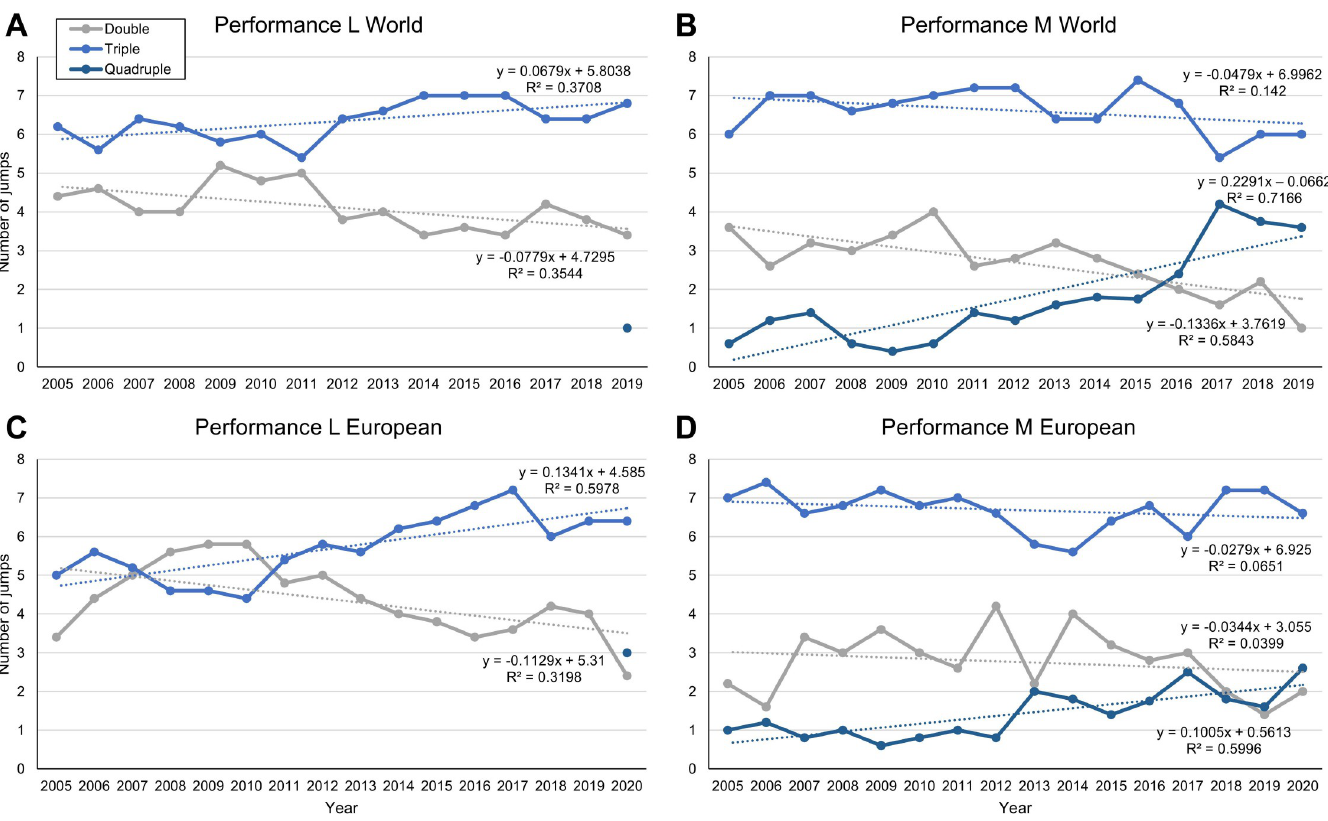
Fig 2. Trends of the average number of double, triple and quadruple jumps. Trends of the average number of double, triple and quadruple jumps of the best five female (L) and male (M) athletes each who competed in the singles categories at the European and World Figure Skating Championships since the year 2005. Regression analysis was performed to show trends over time. The regression function and the coefficient of determination (R 2 ) are shown for each group. (A) and (B): World Championships, (C) and (D): European Championships.